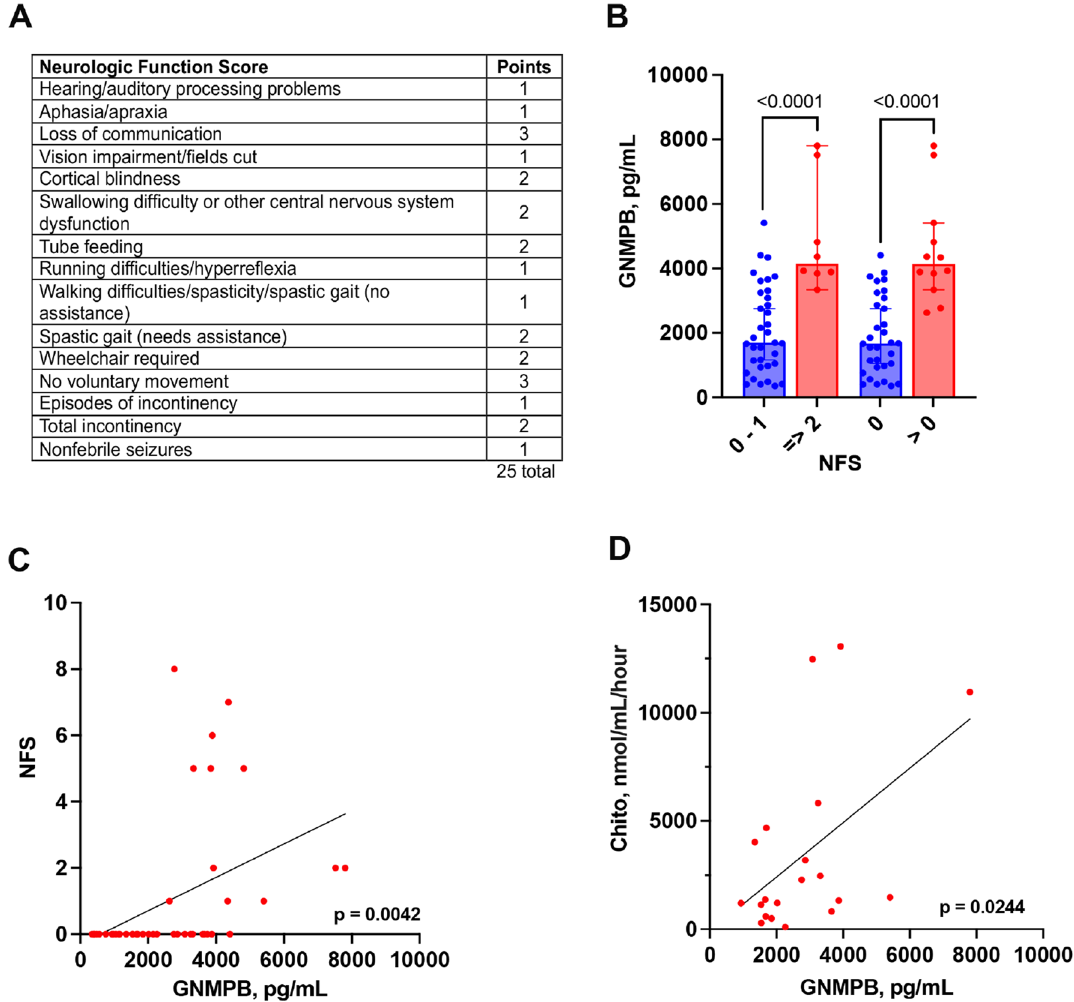
Figure 2. CSF GNMPB correlates with neurologic function and chitotriosidase. ( A ) The cerebral adrenoleukodystrophy neurologic function score (NFS), which was used to evaluate gross clinical neurologic severity for the cALD cohort pre-transplantation. Note that a score of zero denotes absence of clinical signs of cerebral disease. Maximal signs within a domain score the total of all grades within that domain (for example, a patient with “total urinary or fecal incontinency” scores 3, for the sum of “Episodes of incontinency” [1 point] and “Total Incontinency” [2 additional points]). ( B ) The difference between neurologically affected boys (NFS ≥ 2) versus those with NFS ≤ 1 is depicted. ( C ) Use of the NFS as a continuous variable and p -value derived from a linear regression analysis. ( D ) The correlation between CSF GNMBP and CSF chitotriosidase and p -value derived from a linear regression analysis. ( D ) shows the comparison of CSF Two-comparisons shows p -values derived from a Student’s (GIS = 0). Figure 1D shows that individuals with the highest levels of GNMPB also had the most elevated GIS ( p = 0.0082). For individuals with GIS = 0, asymptomatic and without gadolinium enhancement, their GNMPB levels were different from control non-cALD controls (Fig. 1E, p = 0.5118) suggest a link between GNMPB and active cALD. The neurologic function score (NFS) is used to evaluate the neurologic (dys)function in cALD patients, with points accumulated for loss of function in specific domains as originally reported by Moser et al. 9,24 . These results are shown in Fig. 2A. An NFS of 2 or greater has been classified as neurologically abnormal by Moser et al 24 . Fig- ure 2B shows a significant difference between patients with NFS ≤ 1 and those with an NFS of 2 or greater (mean 2095 pg/mL versus 4939 pg/mL, p < 0.0001). There was also a significant difference between those with NFS = 0 (i.e. asymptomatic) and those with 1 NFS point or higher (mean 1905 pg/mL versus 4554 pg/mL, p < 0.0001). We also determined that the NFS, as a linear variable, had a correlation with CSF GNMPB levels (Fig. 2C, p = 0.0042), though the variance was not strong (R 2 = 0.1794). Chitotriosidase is an enzyme released by activated monocytes/ macrophages and microglia and been shown to be a CSF biomarker in Gaucher and cALD 25,26 . Figure 2D shows a positive correlation between CSF GNMPB and CSF chitotriosidase activity (R 2 = 0.2512, p = 0.0244).